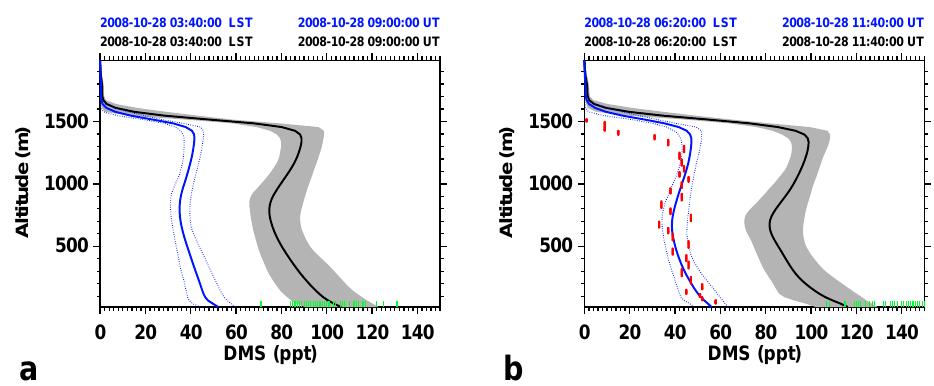
Fig. 10. Comparison of DMS from simulation S 0 (black) and S 1 (blue) at (a) 09:00UT and (b) 11:40UT with VOCALS-REx RF06 POC observations at 11:36UT (red dots) on board the NCAR C-130 aircraft, and surface measurements during a 1h period centered around the indicated times on board the NOAA research vessel Ronald H. Brown (green bars). Solid curves denote the model mean, gray shading and dotted blue curves model values between the 10th and 90th